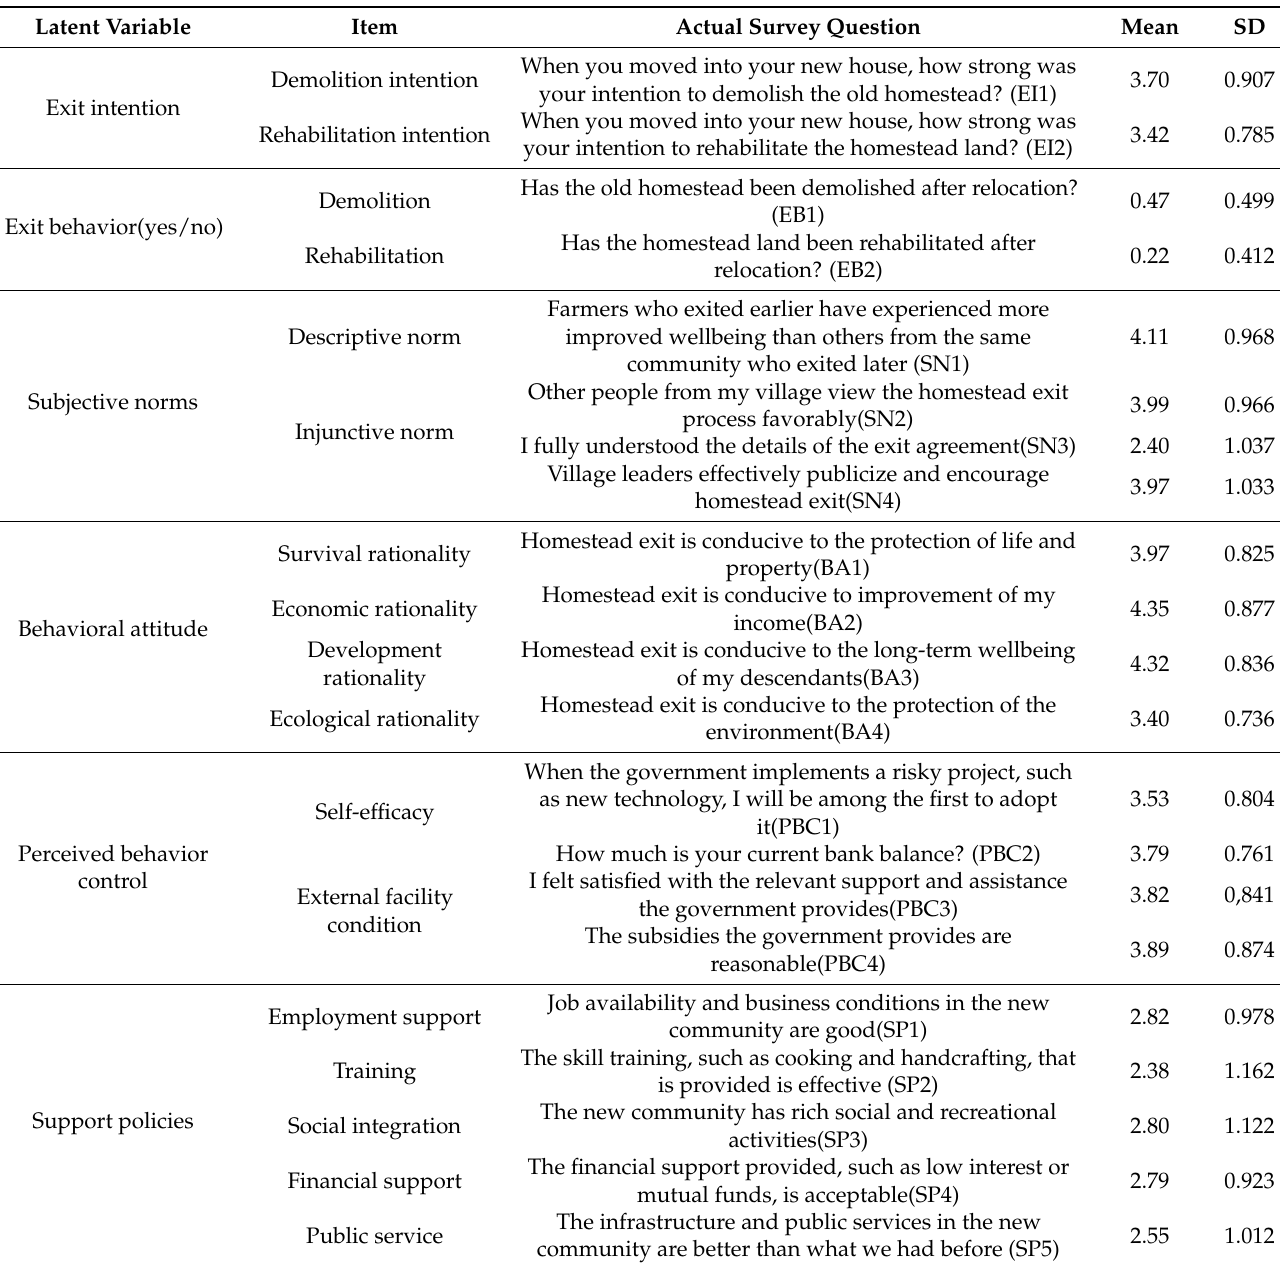
Table 2. Latent and measurable variables used in the model (n =